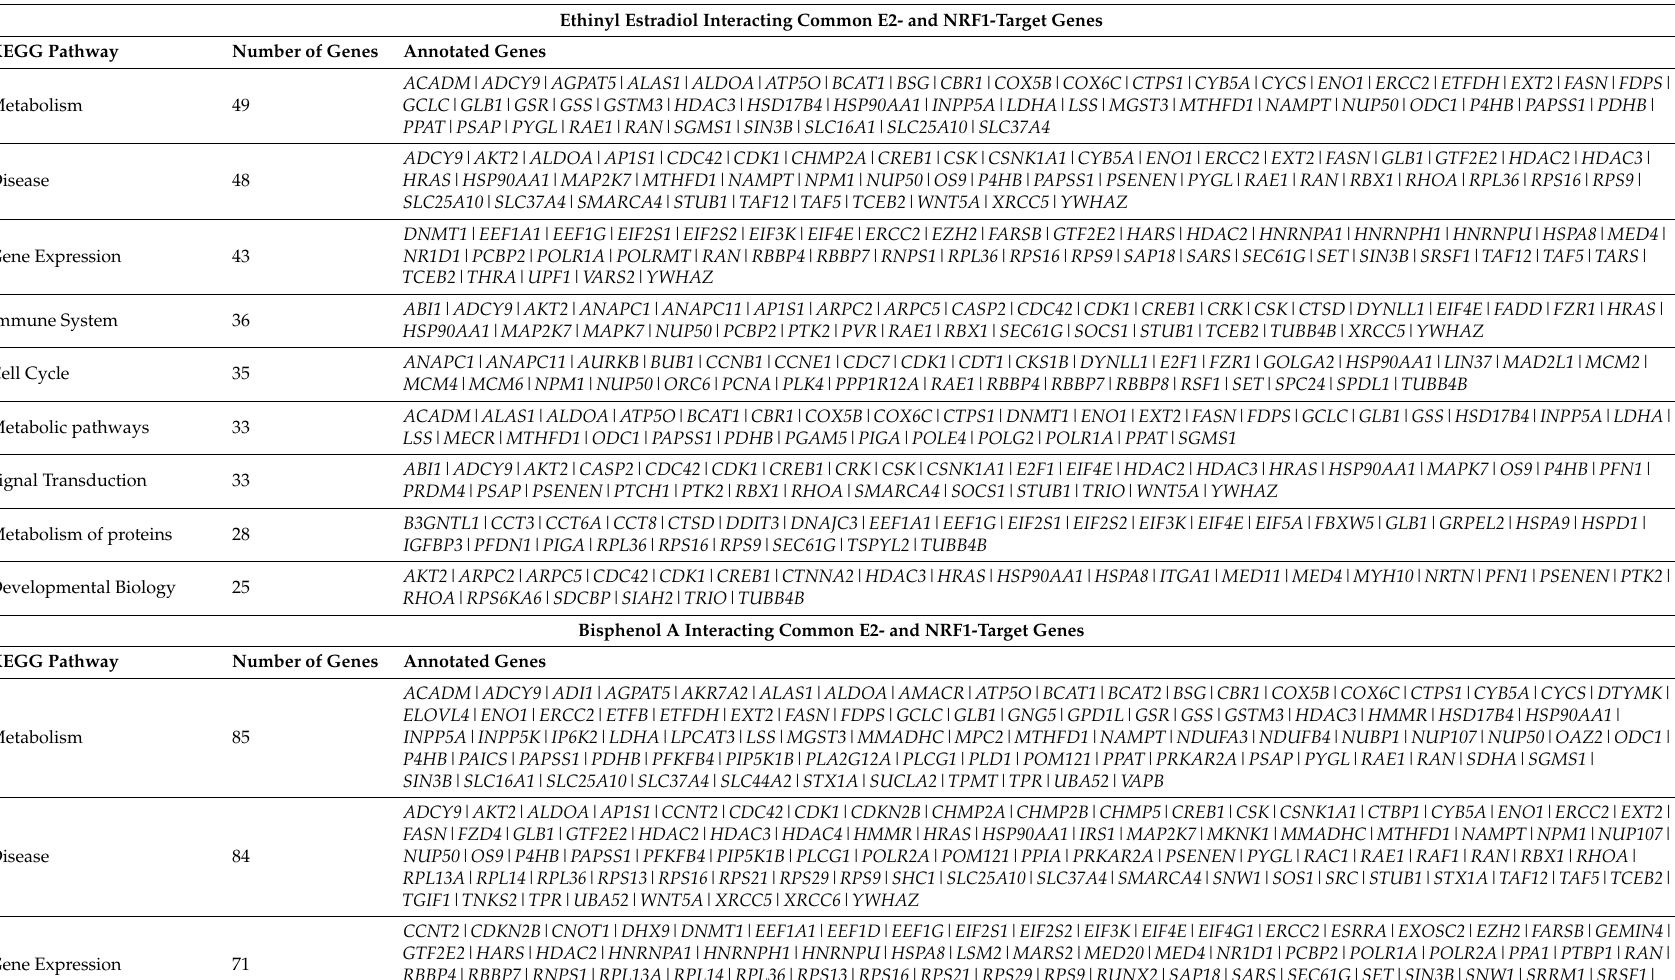
Ethinyl Estradiol Interacting Common E2- and NRF1-Target